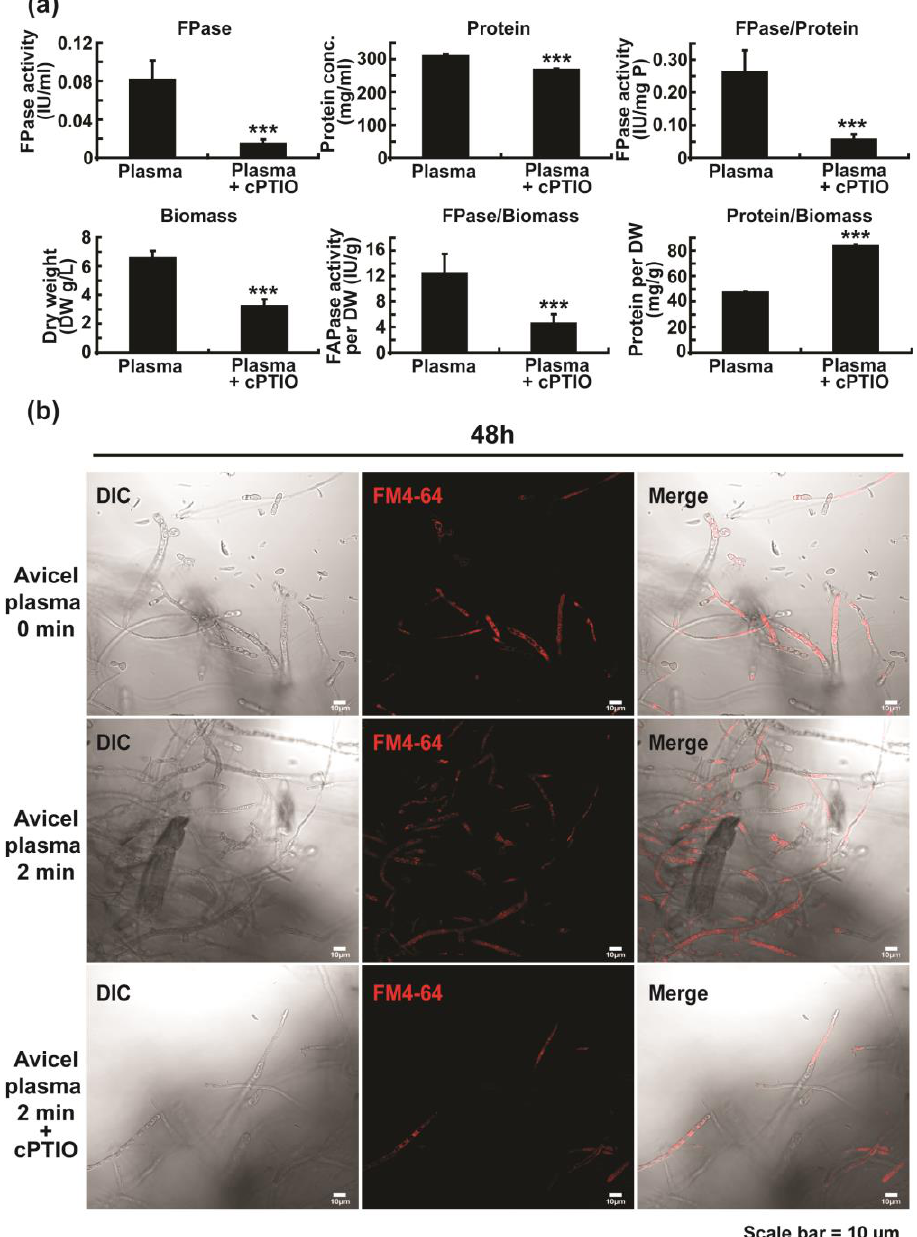
Figure 7. Effects of cPTIO on fungal cellulase production and vesicle accumulation. Fungal hyphae were treated with a plasma jet for 0 min or 2 min and the analysis was performed at 48 h after the addition of cPTIO. ( a ) Effects of cPTIO on total activity of cellulolytic enzymes, total protein concentration, activity of cellulase per mg of secreted protein, fungal biomass, activity of cellulolytic enzymes per g of biomass, and secreted protein per g of biomass. Each value represents the mean of 9 – 12 replicate measurements: *** p < 0.001. ( b ) Fungal hyphae vesicles stained with FM4-64 48 h after the addition of cPTIO.